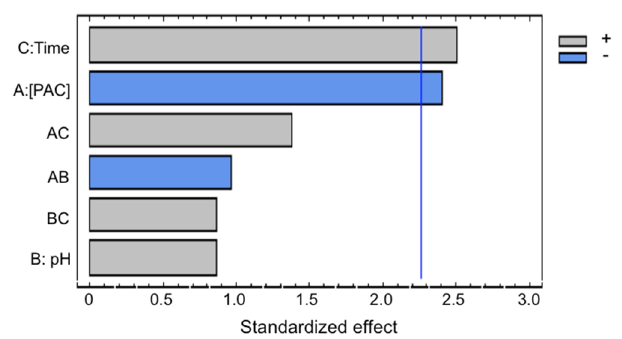
Figure 2. Pareto diagram of coagulation / sedimentation experiments with PAC coagulant.